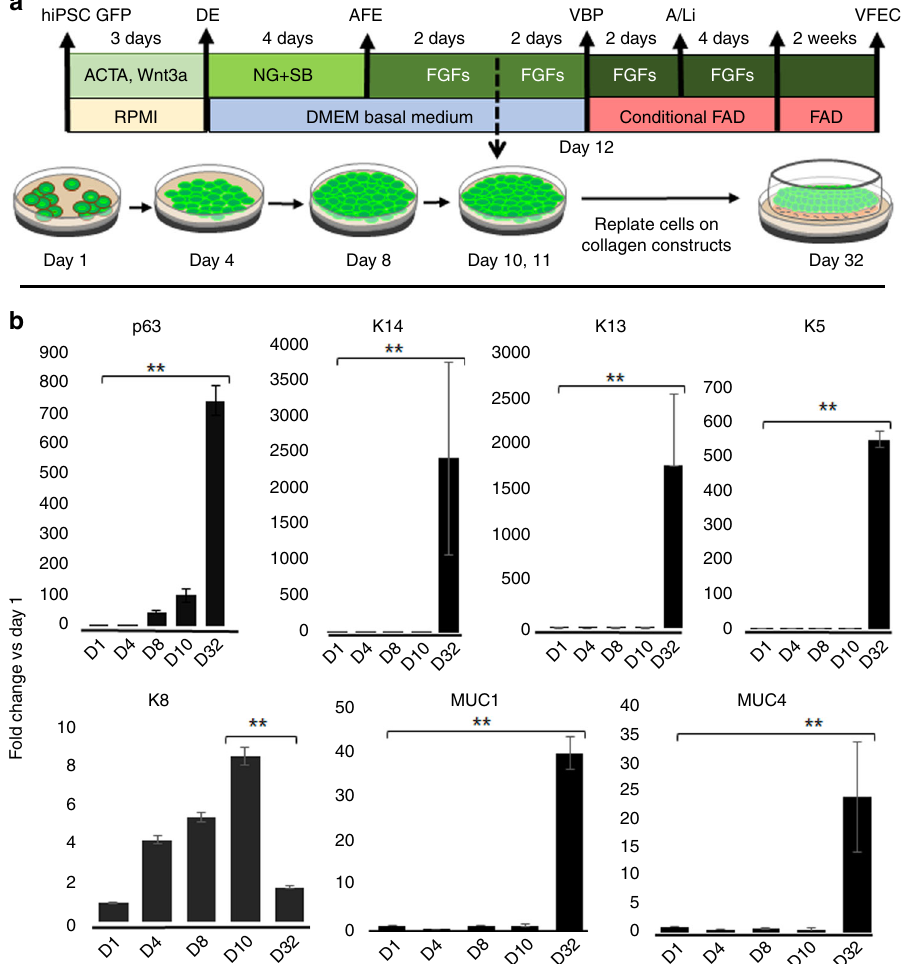
Fig. 4 Generation of 3D hiPSC-derived human VF mucosa. a Protocol for generation of human induced pluripotent stem cell-derived vocal fold mucosa through DE and AFE. b Comparison in expression levels of p63, Cytokeratin 14, 13, 5, and 8, and Mucin 1 and 4 between fully differentiated hiPSC-derived VFEC after 32 days in culture and earlier stages of differentiation. VFEC were isolated from the entire constructs at day 32. We used one-way ANOVA to assess statistical signi fi cance for tested genes. All of the p- values for tested genes were below the threshold p- value < 0.01 (expressed as **), indicating that expression levels of tested genes in fully differentiated hiPSC-derived VFEC signi fi cantly differed from the expression levels of these genes in hiPS cells, DE, AFE, and VBP. ACTA Activin A, AFE anterior foregut endoderm, DE de fi nitive endoderm, hiPSCs human induced pluripotent stem cells, NG Noggin, VBP vocal fold basal progenitors, VFEC vocal fold epithelial cells. Source data provided as a Source Data fi